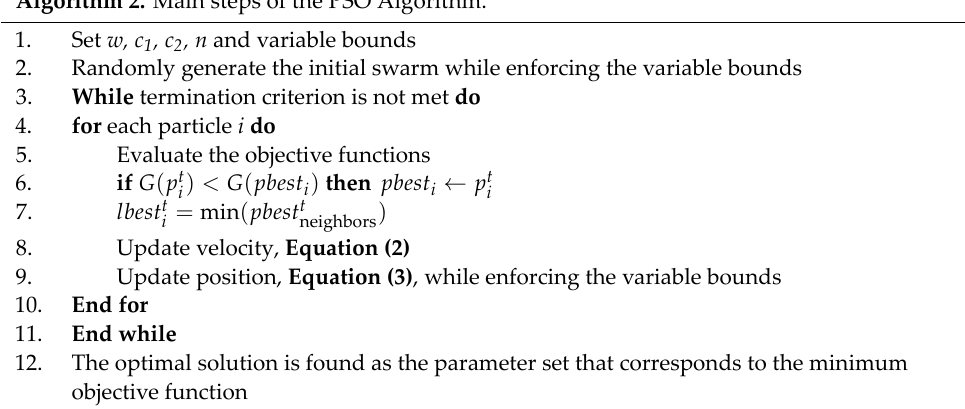
Algorithm 2. Main steps of the PSO